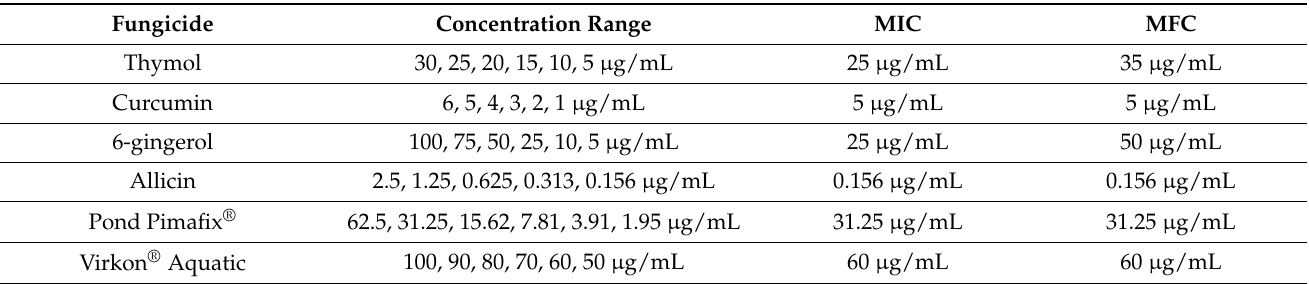
Table 1. Concentrations tested and minimum inhibitory concentration (MIC) and minimum fungici- dal concentration (MFC) estimated for evaluating the effect of six fungicides on Bsal zoospore